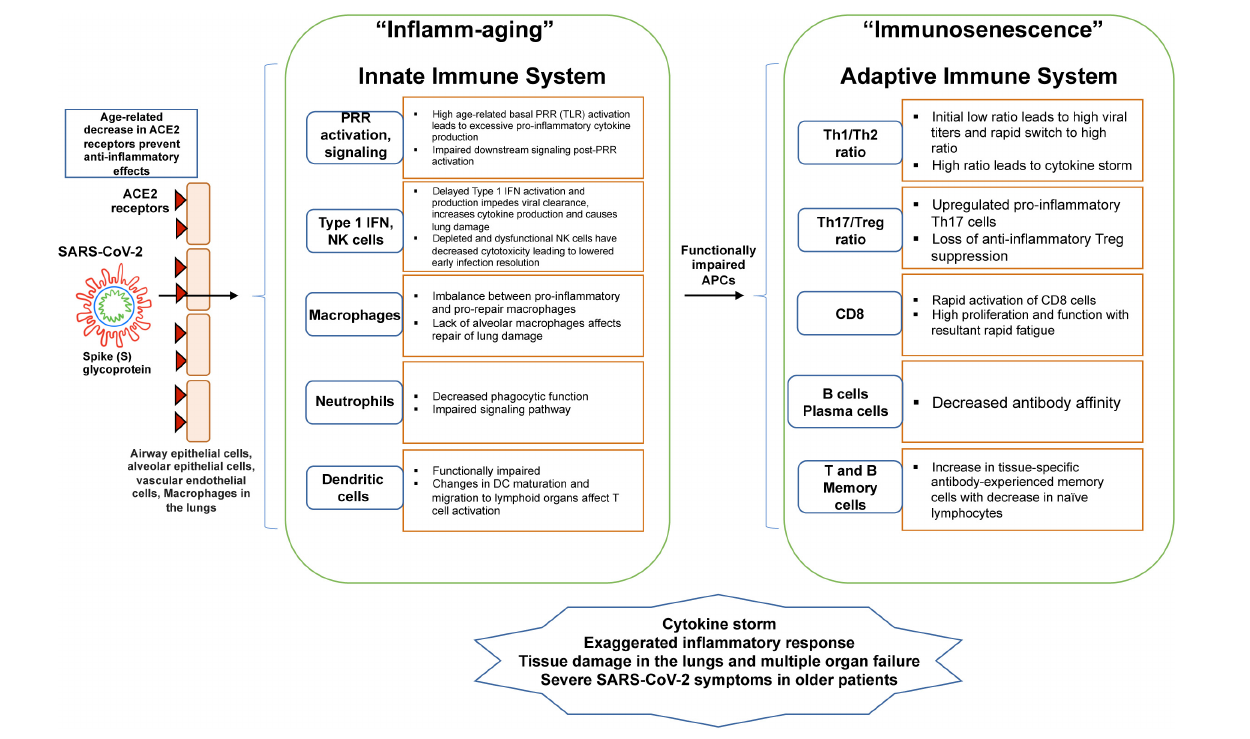
FIGURE 1 | Schematic shows age-related changes in the innate and adaptive immune system with relevance to COVID-19. As the SARS-CoV-2 enters parenchymal cells expressing the ACE2 receptor, it activates PRR of the innate immune system. With aging, there is an imbalance in cellular functions and signaling, decreasing innate activation of an already weakened adaptive immune system. These imbalances lead to “inflammaging” from proinflammatory innate immune responses and immunosenescence of the adaptive immune